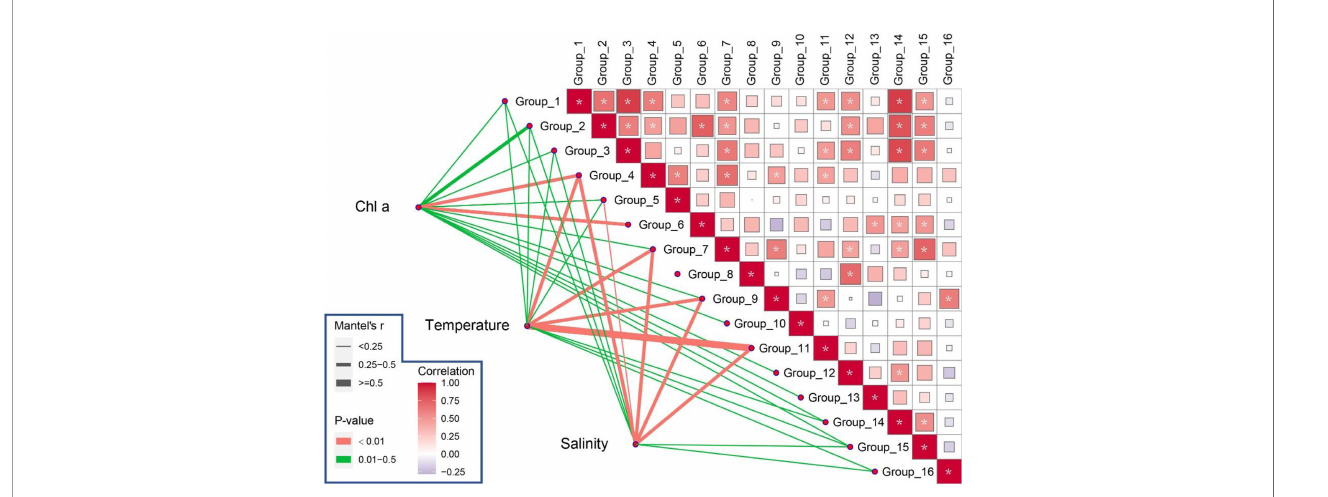
FIGURE 7 | Interaction pro fi le within and between groups and environmental factors by correlation analyses (* p <